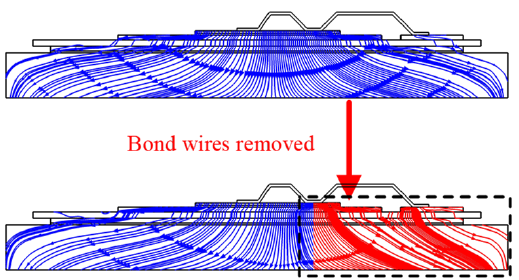
M _ HS ; ( b ) aging ratio K .